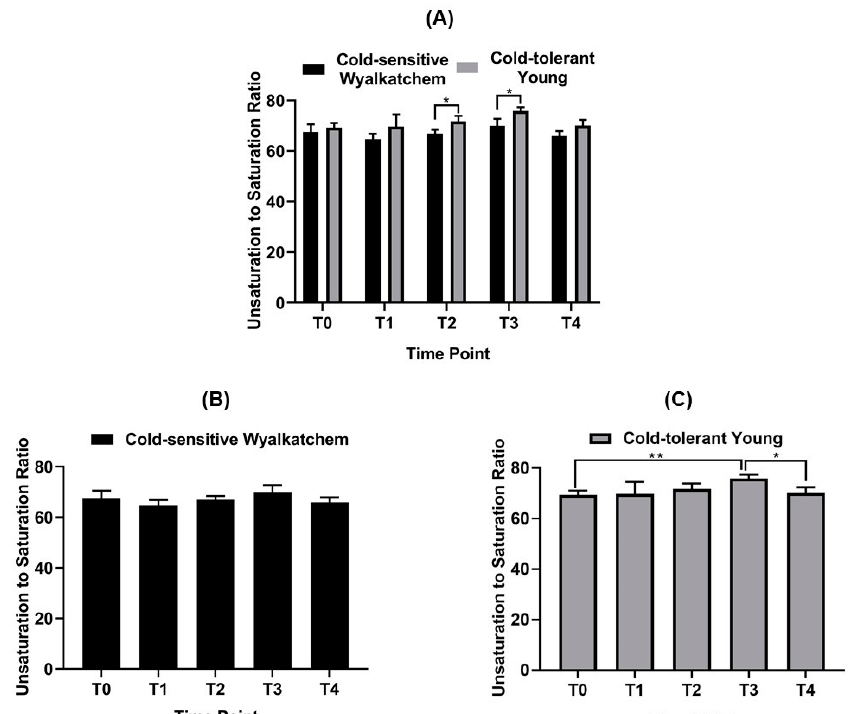
Figure 5. ( A ) Comparison of unsaturated to saturated lipid ratio between Wyalkatchem and Young across the time points. ( B ) Comparison of unsaturated to saturated lipid ratio in Wyalkatchem across the time points. ( C ) Comparison of unsaturated to saturated lipid ratio in Young across the time points. Student’s t -test was used to compare the ratio for a time point with its following time point. Error bars indicate the standard error mean (SEM) of three biological replicates ( n = 3). Significantly different ratios were labelled with an asterisk (* = p < 0.05, ** = p < 0.01).